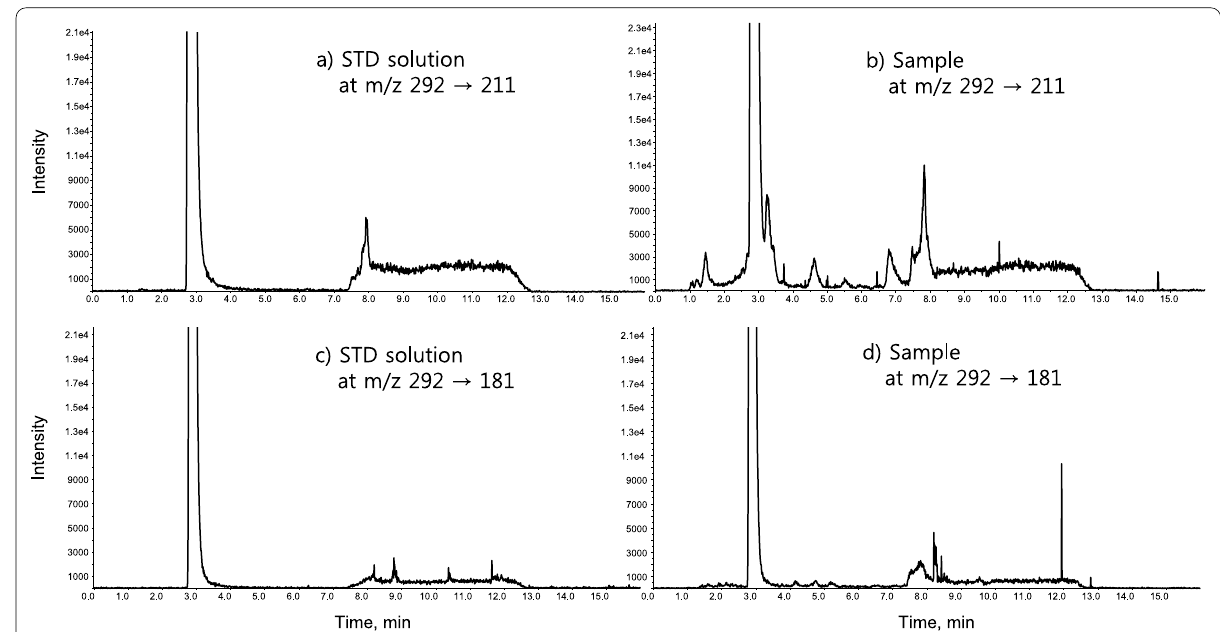
Fig. 3 Comparison of the thiamethoxam MS/MS channels between m / z 292 standard solution and b kimchi cabbage sample with the channel of m / z 292 and d kimchi cabbage sample with the channel of m / z 292